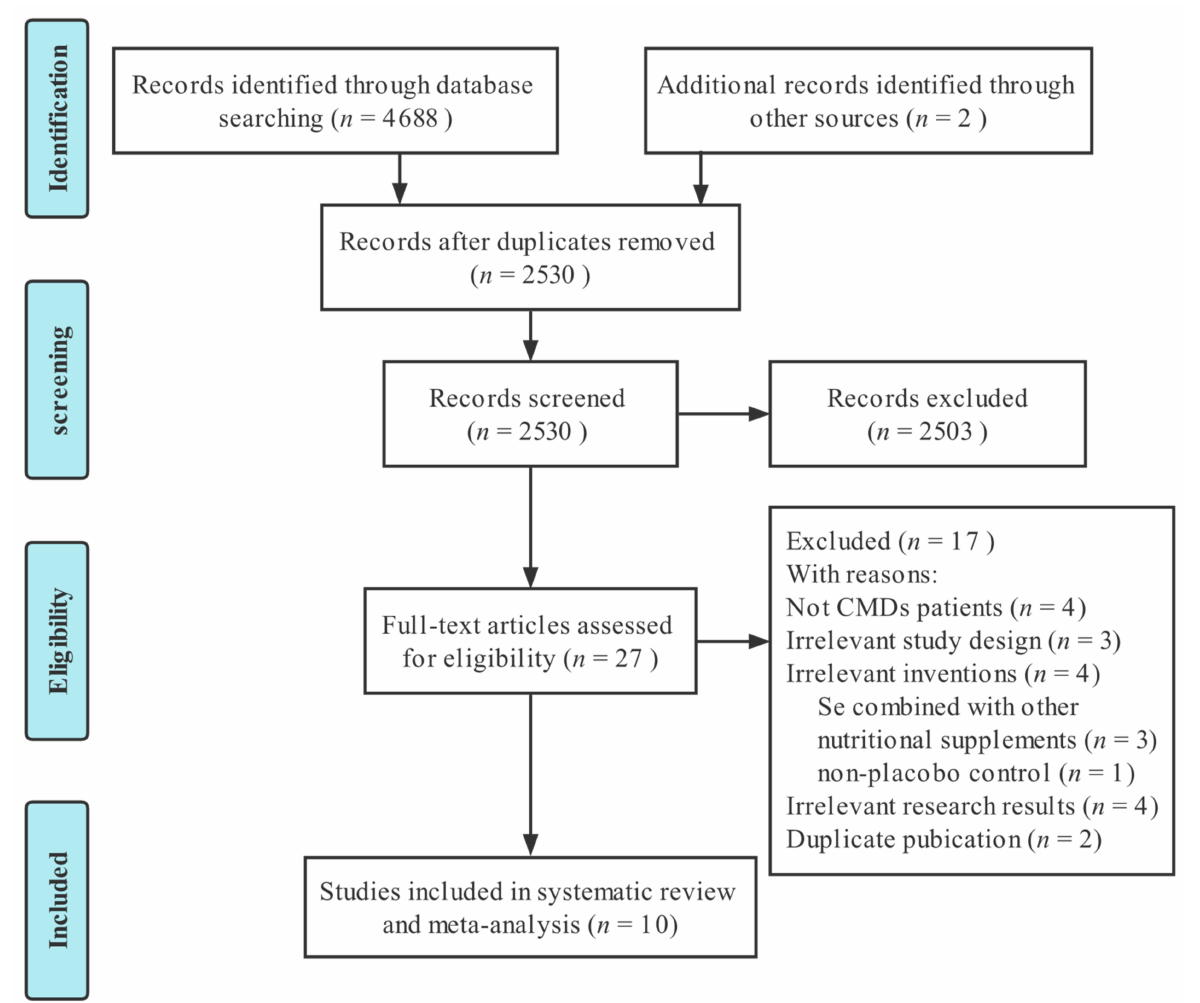
Figure 1. PRISMA flow chart for selection and screening of the